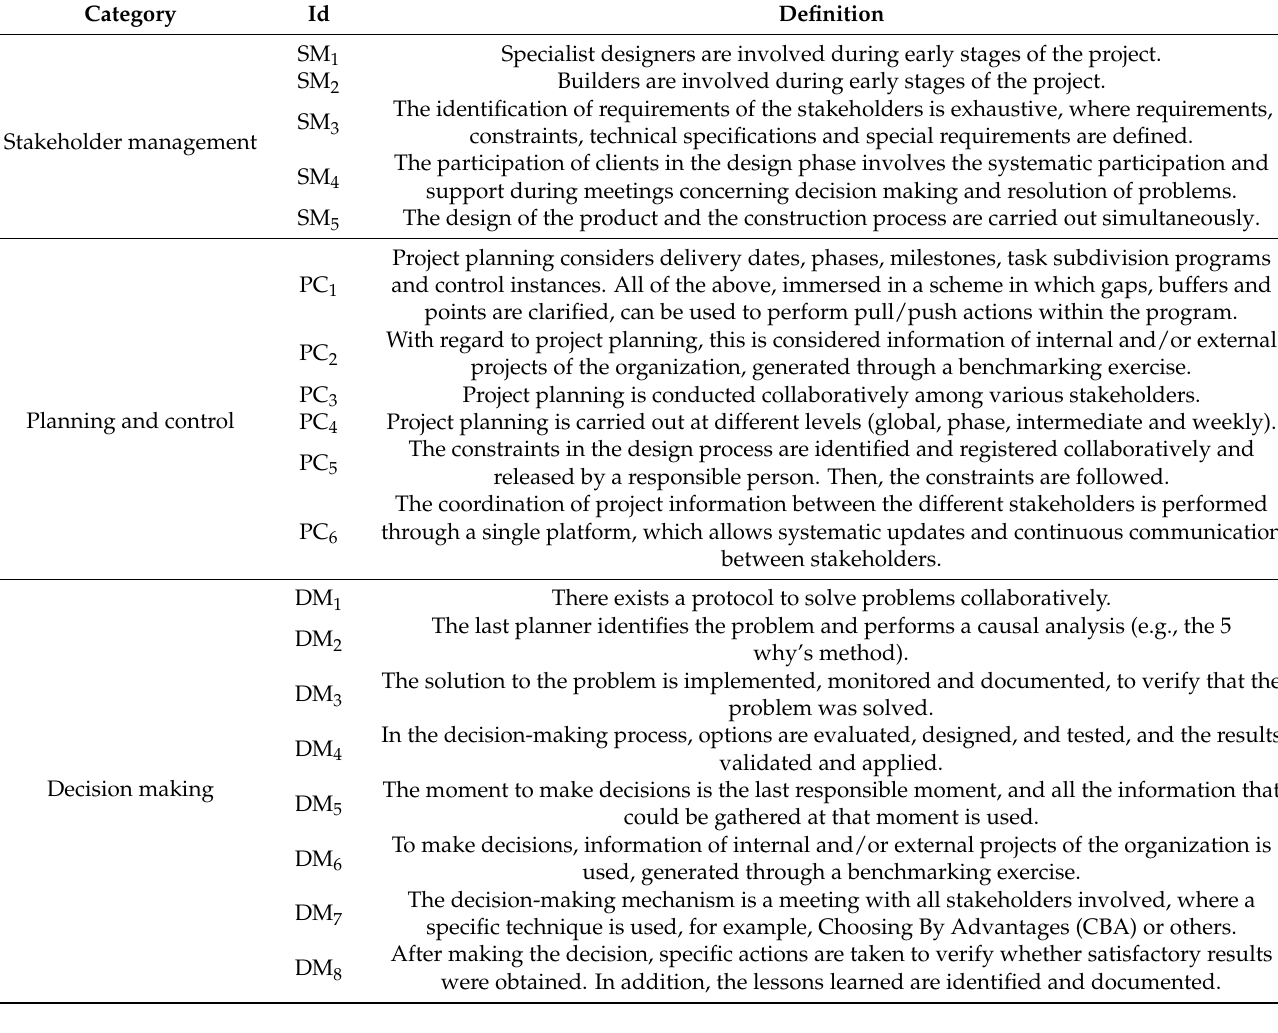
Table 1. Lean design management (LDM) practices. Adapted from